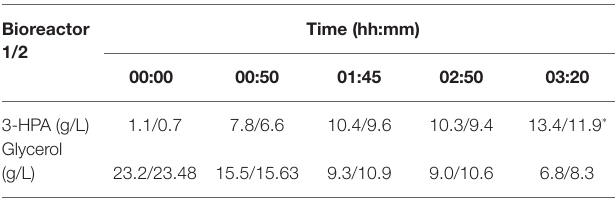
TABLE 1 | 3-hydroxypropionaldehyde (3-HPA) and glycerol content in the supernatant at different time points in a duplicate approach.